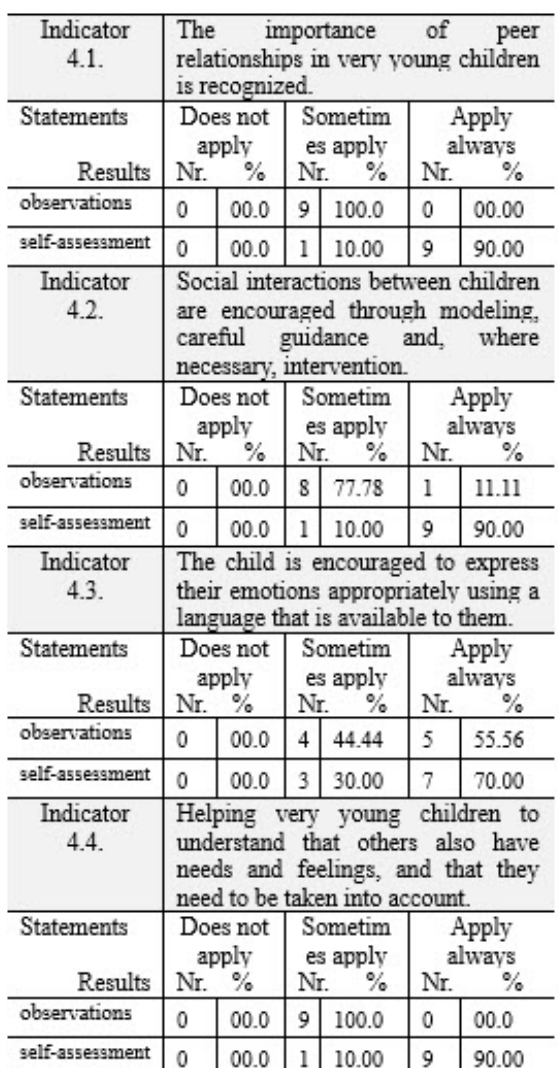
Table 4. Principle 4: Relationships be - tween the children themselves are stimulated.